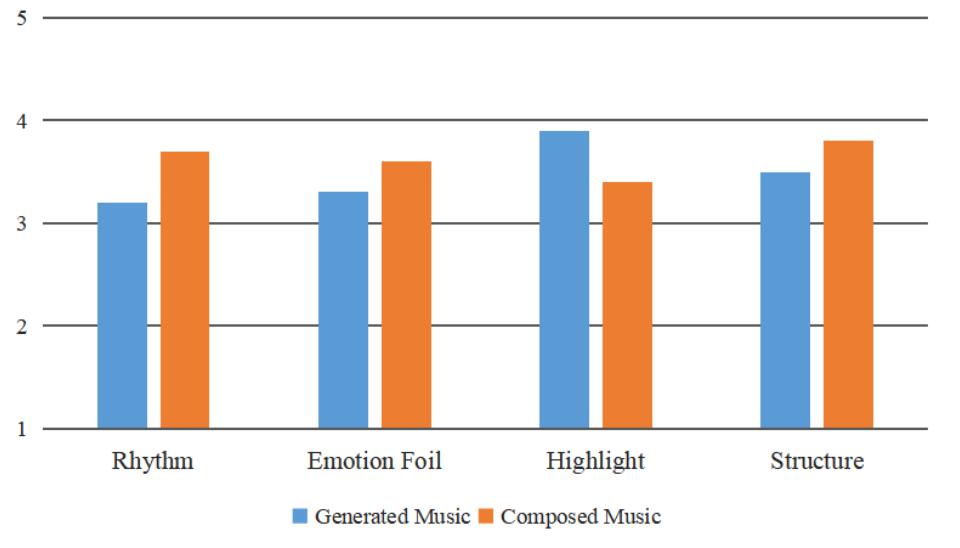
Figure 8. The average result from the evaluation group without music knowledge background on two kind of music pieces on different indicators of night